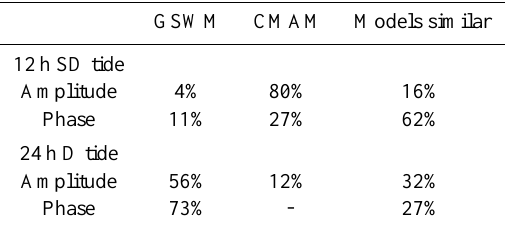
Table 1. Percentage of “better” matches GSWM CMAM Models